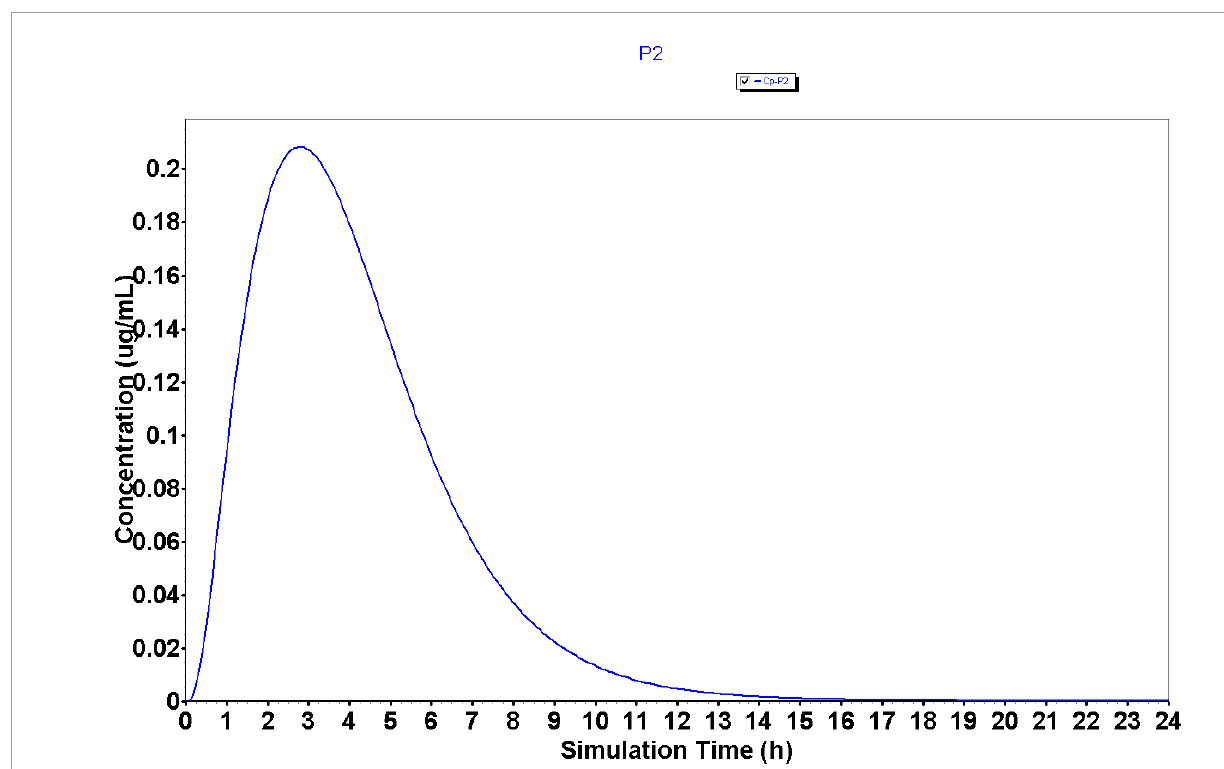
Figure 5. Plasma concentration of P2 generated using the GastroPlus ® software.